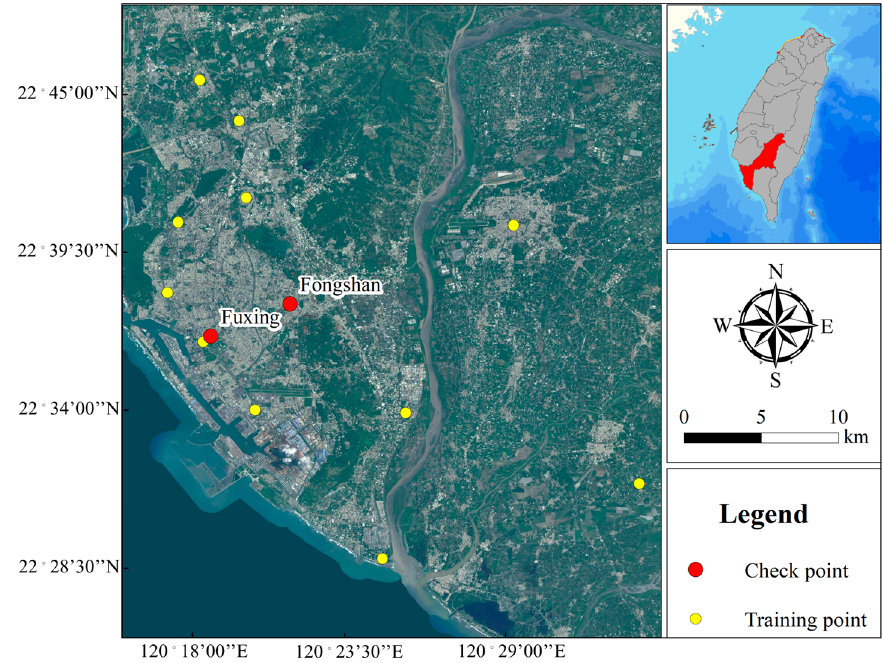
Figure 2. Distribution diagram of training and independent testing stations.